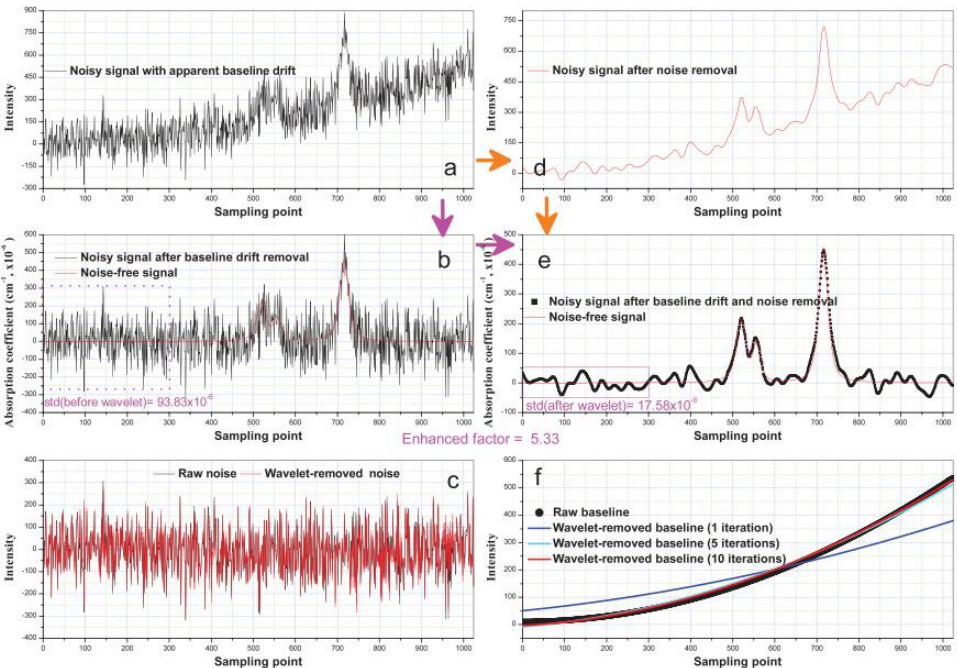
Figure 11. Nonlinear baseline correction and denoising using discrete wavelet transform (DWT). ( a ) Noisy signal with apparent baseline drift; ( b ) baseline drift-removed signal from ( a ) and noise-free signal; ( c ) raw noise and wavelet-removed noise; ( d ) denoised signal from ( a ); ( e ) baseline drift-removed signal from ( d ) and noise-free signal; ( f ) raw baseline and wavelet-removed baselines with different iterations. Figure adapted from [98].